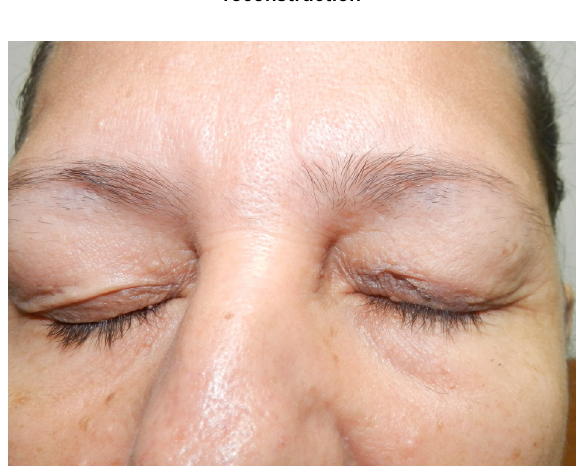
Figure 4: Appearance of the eyelid at the end of the reconstruction